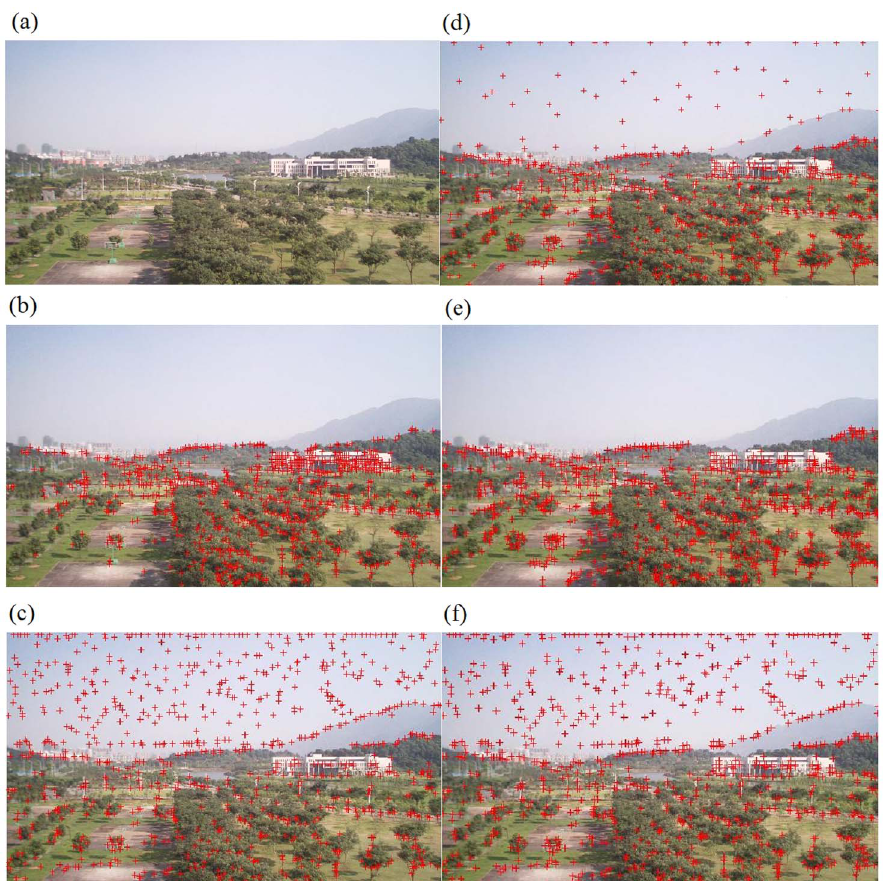
Figure 3. Experiments on corner selection: (a) Original image; (b) Harris detector; (c) The regional corner-selection algorithm; (d) Our algorithm with t ~ 10 ; (e) Our algorithm with t ~ 30 ; (f) Our algorithm with t ~ 1 . doi:10.1371/journal.pone.0081182.g003 PLOS ONE |